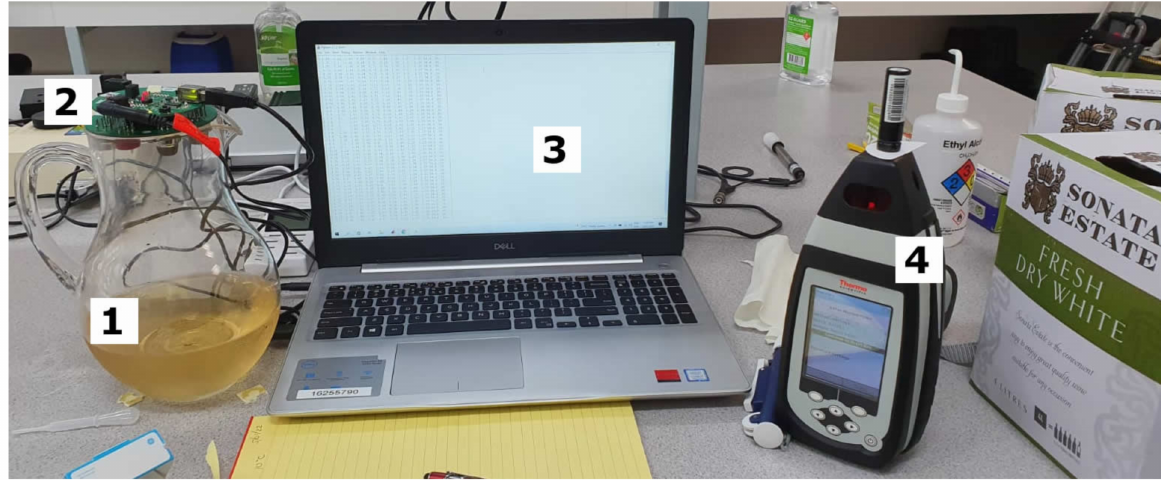
Figure 1. Example of setup used to measure: ( 1 ) wine samples using a ( 2 ) low-cost electronic nose connected to a ( 3 ) personal computer to collect and save data, and ( 4 ) MicroPHAZIR™ RX